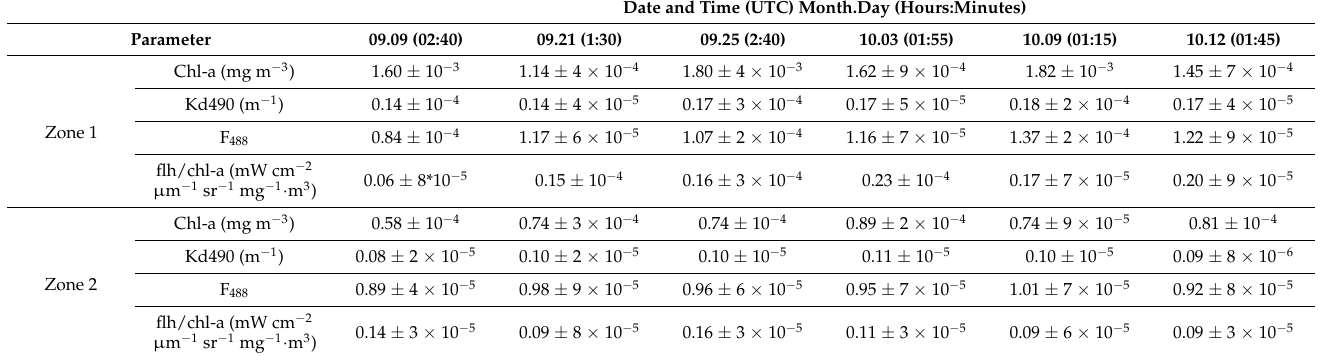
Table 2. Variability of average values of bio-parameters in the Avacha Gulf in coastal and open-ocean